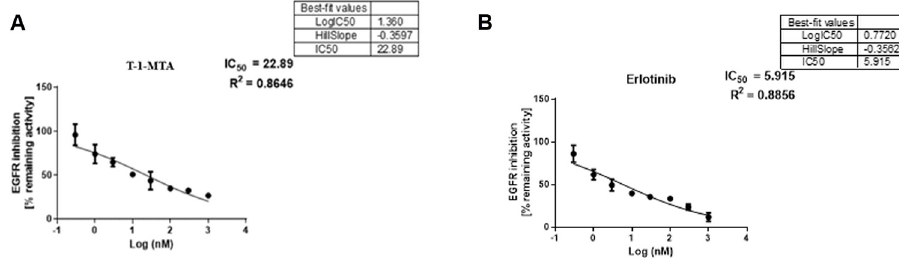
Fig 17. In vitro EGFR- inhibition potentialities of T-1-MTA (A) and erlotinib (B).